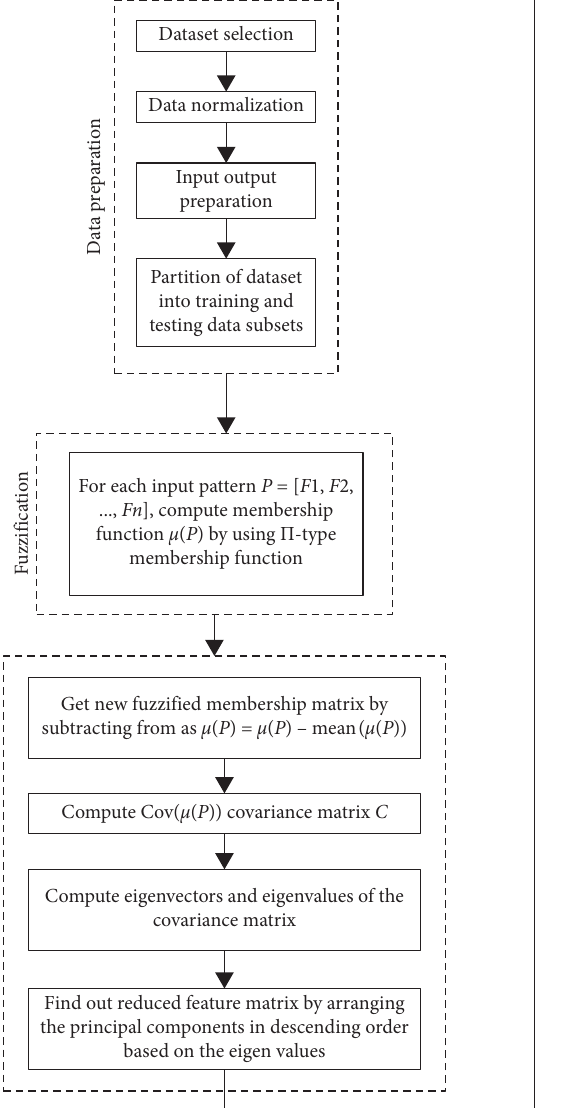
Figure 3: The detailed working model of proposed